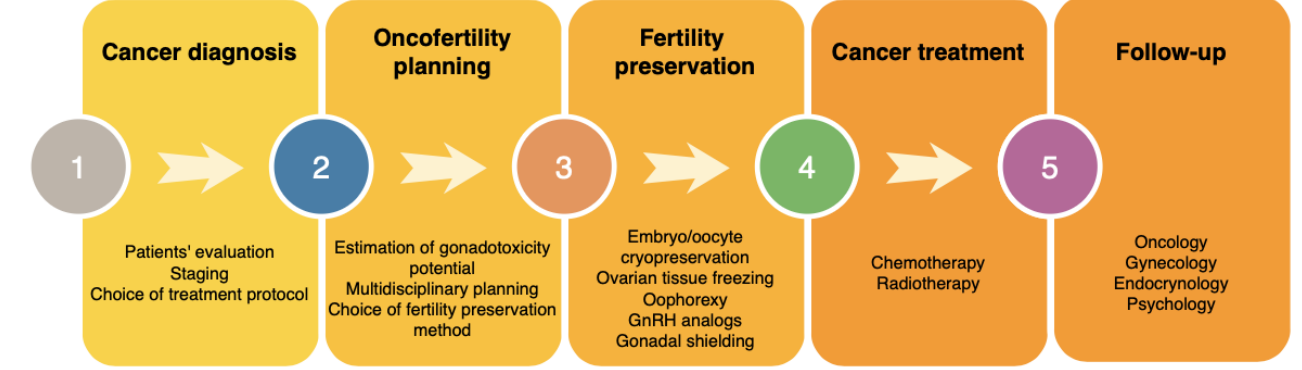
Figure 1. Oncofertility management of females diagnosed with cancer.